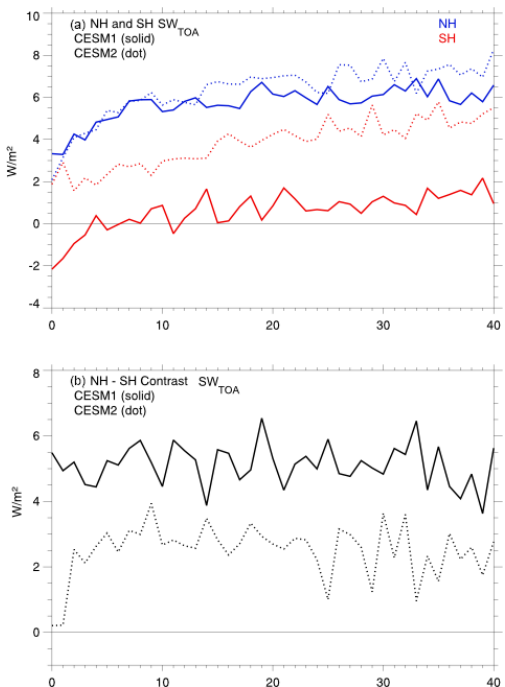
Figure A5. Time series of hemispheric mean absorbed TOA short- wave fluxes in CESM1 and CESM2 (a) and their differences (b) in abrupt4 × CO 2 simulations.